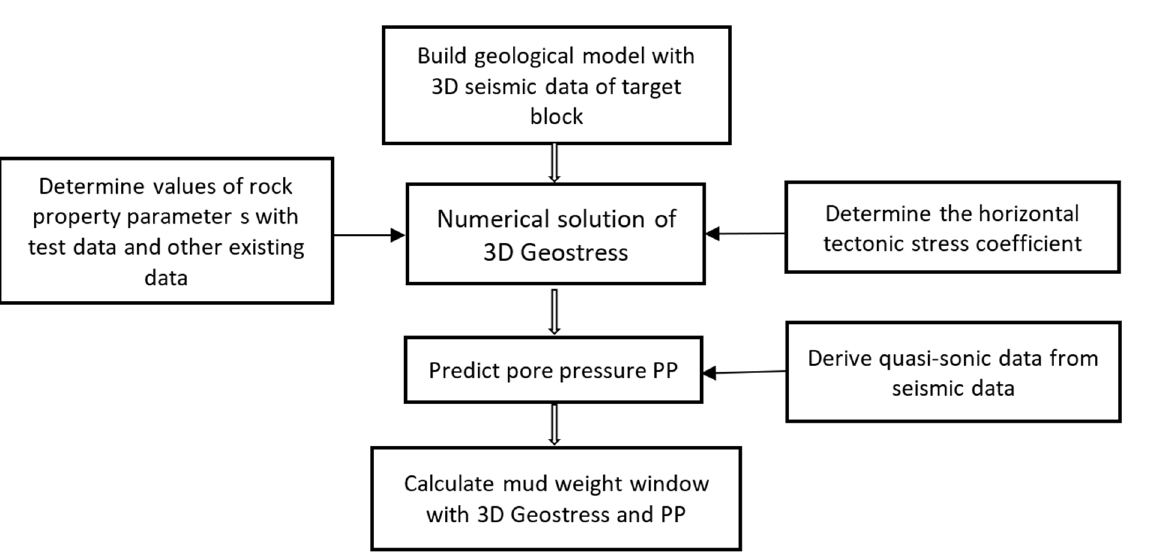
Figure 2. ( a ) Profile and structure of a main survey line of Tugulu anticline of TS Block. ( b ) A sec ‐ tional view of a survey line across well LT ‐ 1.